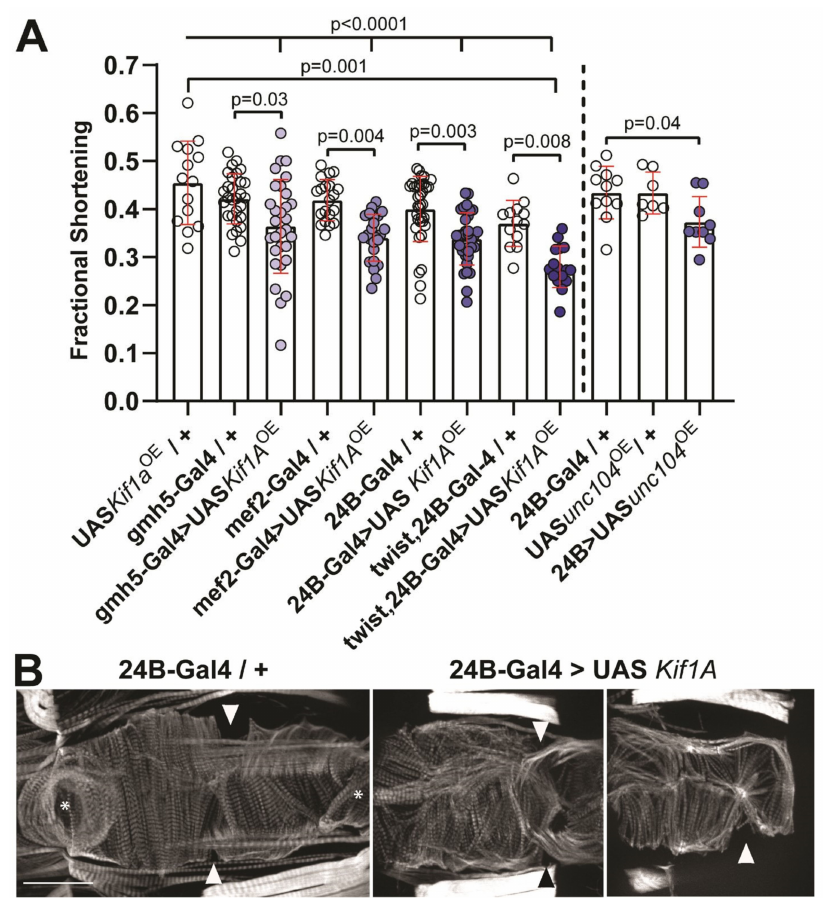
Figure 2. Kif1A overexpression causes reduced contractility and increased myofibrillar disarray: ( A ) Mesodermal (Twist;24B-Gal4 and 24B-Gal4, and mef2-Gal4) and cardiac-specific (GMH5-Gal4) drivers were used to drive (left) Kif1A and (right) unc104 overexpression in the hearts of 3-week-old flies. In all cases, overexpression of mouse Kif1A or fly unc104 significantly reduced fractional shortening, a measure of cardiac contractility, compared to controls. Significance was determined using a one-way analysis of variance and Tukey’s multiple comparisons post hoc test; number of flies in each group is shown in Supplementary Table S1. ( B ) Hearts from 3-week-old adult flies stained for F-actin: Control hearts (24B-Gal4 /+ ) show compact myofibrillar structure and well-defined ostia (inflow tracts, arrowhead) and valve (asterisk). Kif1A overexpression resulted in hearts with primarily thin and disorganized myofibrils within the cardiac myocytes with many gaps due to myofibrillar disarray. For orientation purposes, the location of the inflow tracts is indicated by arrowheads. Scale bar is 50 microns; anterior is to the